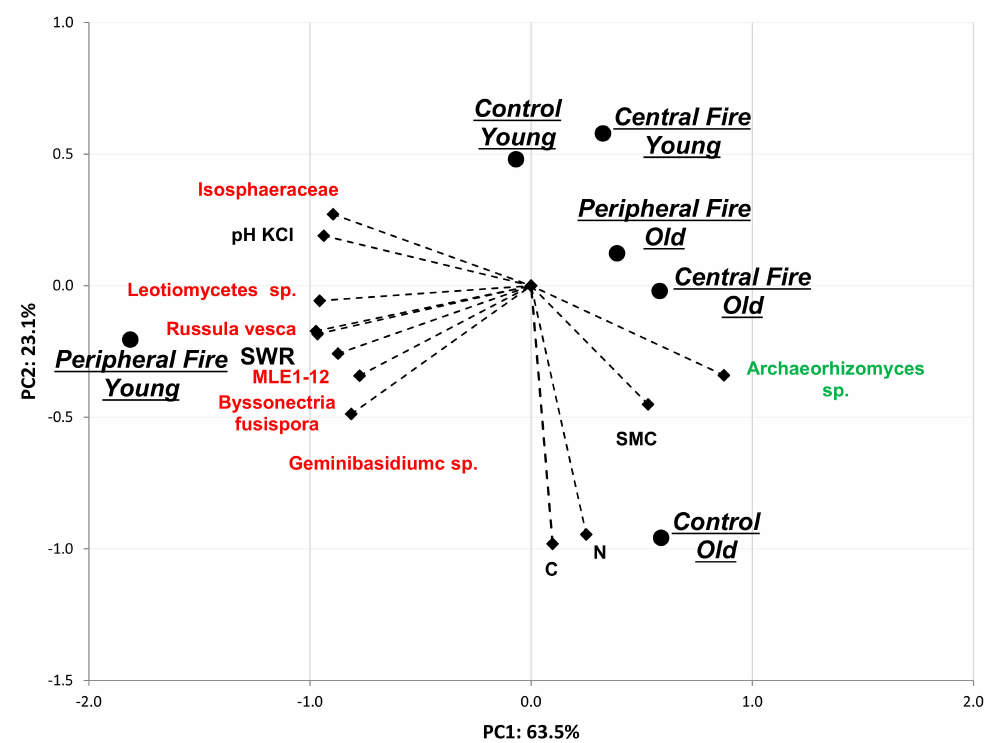
Figure 5. Results of principal component analysis (PCA) of relative abundances of fungal and prokaryote species and the statistically significant relation with soil water repellency (SWR) from the Control Site, Peripheral Fire Site, Central Fire site; Young—young pine stand, Old—old pine stand sites and environmental variables. All genera with > 0.01% abundance and a statistically significant relationship with SWR based on correlation coe ffi cients were considered. Note: SMC—soil moisture content; N—nitrogen; C—carbon; pH KCl. PCA was calculated using means, which were calculated using 3